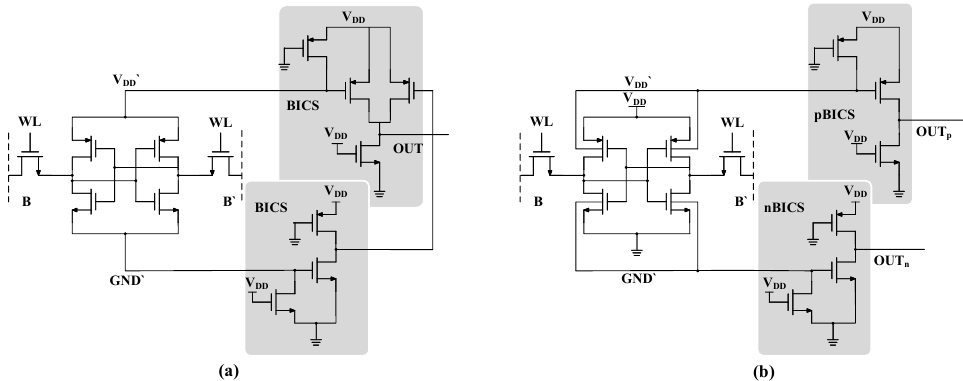
Figure 8. Built in current sensors connected to ( a ) power supply and ( b ) bulk of the devices